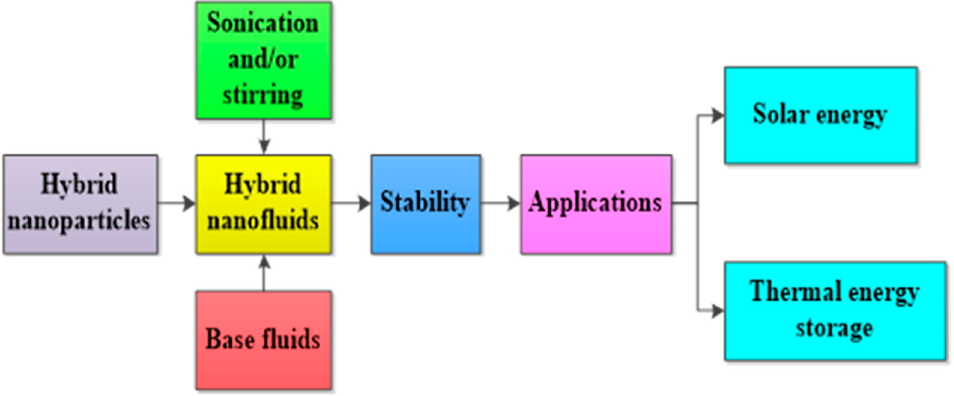
Figure 3. A schematic presentation of this present work.